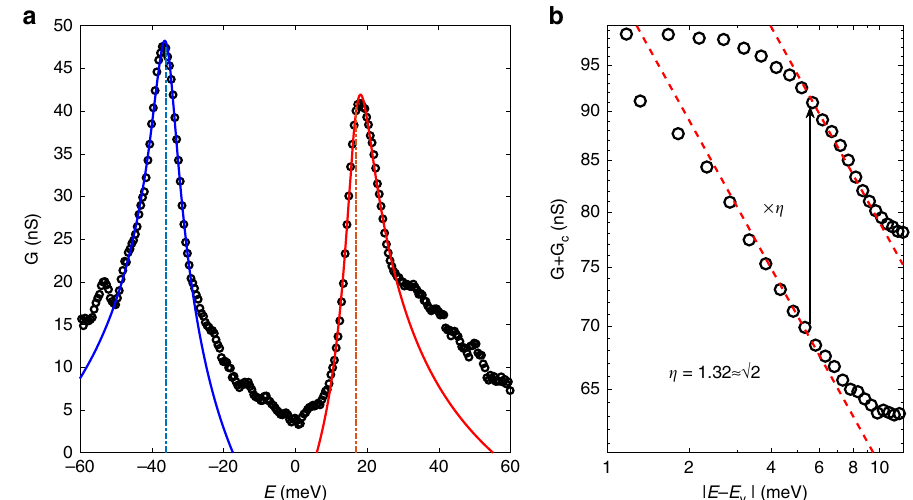
Fig. 1 Theoretical fi t to the tunneling conductance measurement 26 . a Open circles are tunneling conductance G of twisted bilayer graphene at twist angle 1 : 10 (cid:3) , and solid lines are fi tting according to Eq. (5) with details given in the Supplementary Material Sec. I. Dashed lines denote singularity energies, indicating the asymmetry of conductance peaks. b The peak at E two parallel lines with the same slope (cid:4) 1 = 4 and asymmetry ratio η ¼ 1 : 32 (cid:1)